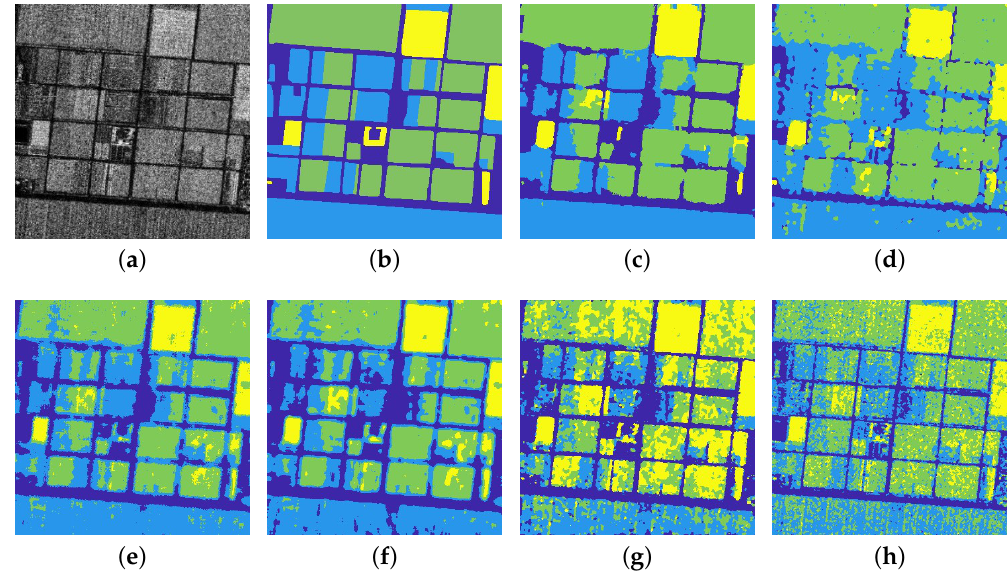
Figure 17. Segmentation results: ( a ) experimental image, ( b ) ground truth, ( c ) proposed,